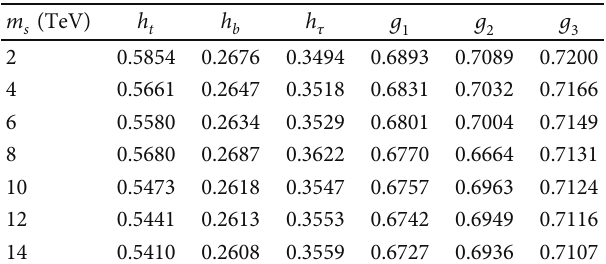
Table 6: Values of Yukawa and gauge couplings evaluated at t = ln ð 10 16 GeV Þ = 36 : 84 for tan β = 40 , for di ff erent choices of m scale.